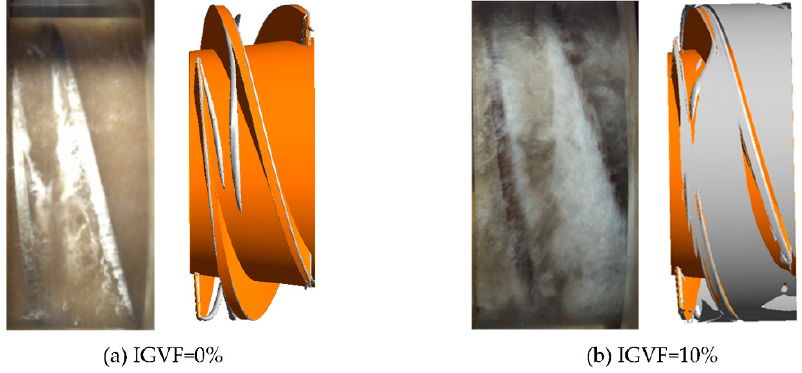
Figure 5. The experimental and CFD flow fields.